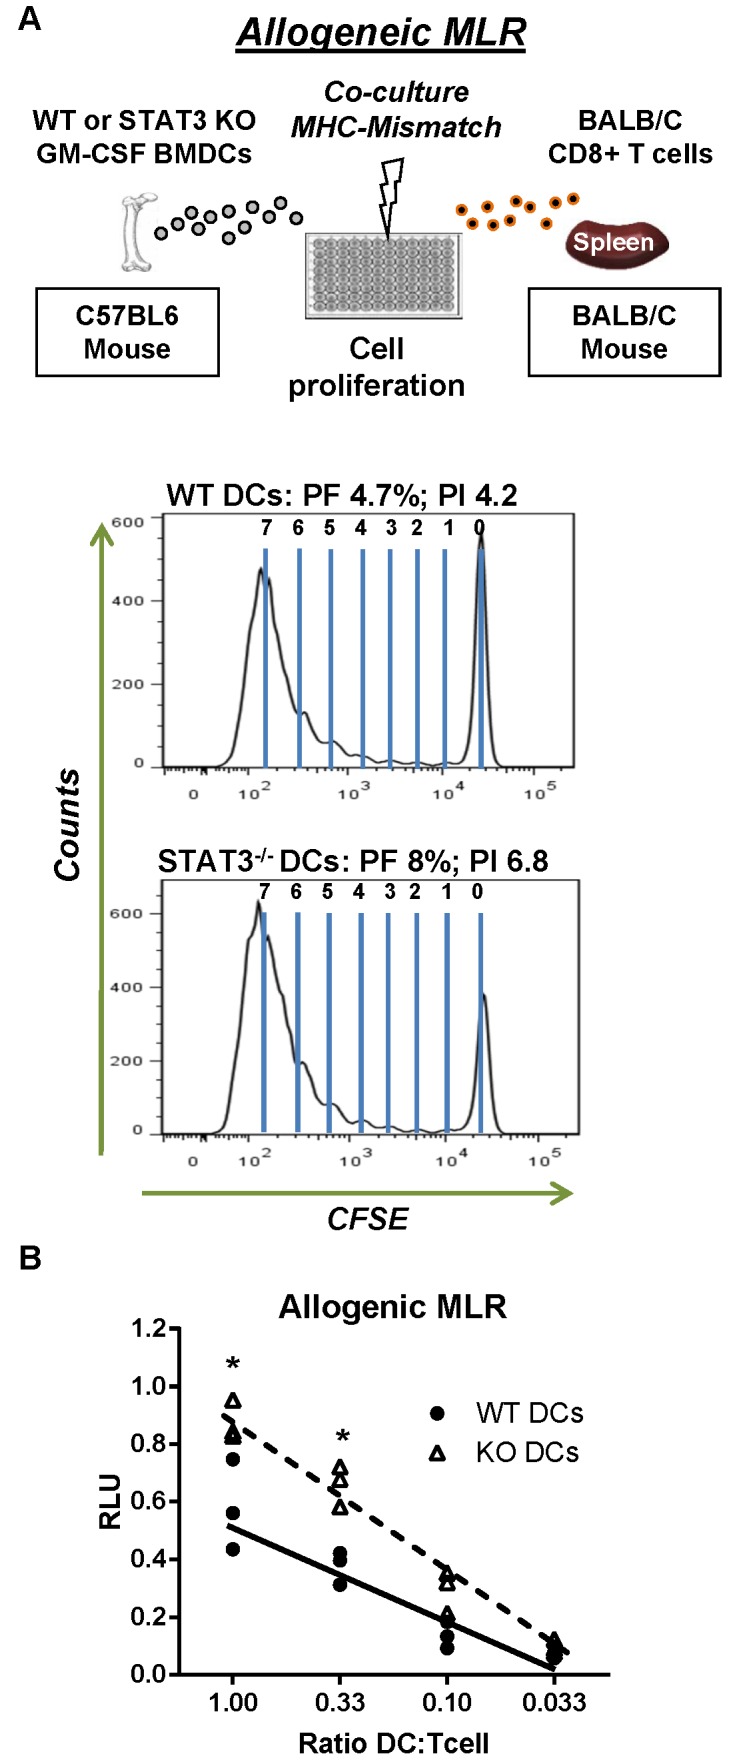
Deletion of STAT3 in DCs enhances the proliferation of allogeneic T cells.
A. An allogeneic mixed lymphocyte reaction (MLR) was used to determine if DCs (stimulator) could induce allogeneic T cell (responder) proliferation. WT and STAT3−/− DCs were derived using GM-CSF as previously outlined. BMDCs were stimulated with CpG 1668 (500 ng/ml) for 12 hours to increase cell surface expression of MHC-II prior to being γ-irradiated. To induce proliferation, 100,000 DCs were cultured with CFSE-labeled allogeneic T cells at a 1∶1 ratio in 96-well flat bottom wells for 5 days. CFSE intensity of CD8+ T cells at day 5 is presented as histograms. The precursor frequency and proliferation index were derived using the proliferation analysis wizard in Modfit LT computer software. B. CpG-matured DCs were irradiated and cultured with 100,000 allogeneic T cells at decreasing ratios of stimulator to responder in 96-well flat bottom wells. Cells were allowed to proliferate for 4 days prior to addition of the nucleotide analogue BrdU (18 hours incubation). Incorporation of BrdU into dividing DNA was determined using a colorimetric ELISA kit. 2-way ANOVA test followed by Tukey-Kramer multiple comparison test were employed to determine statistical significance (*, p<0.05 versus wild type).